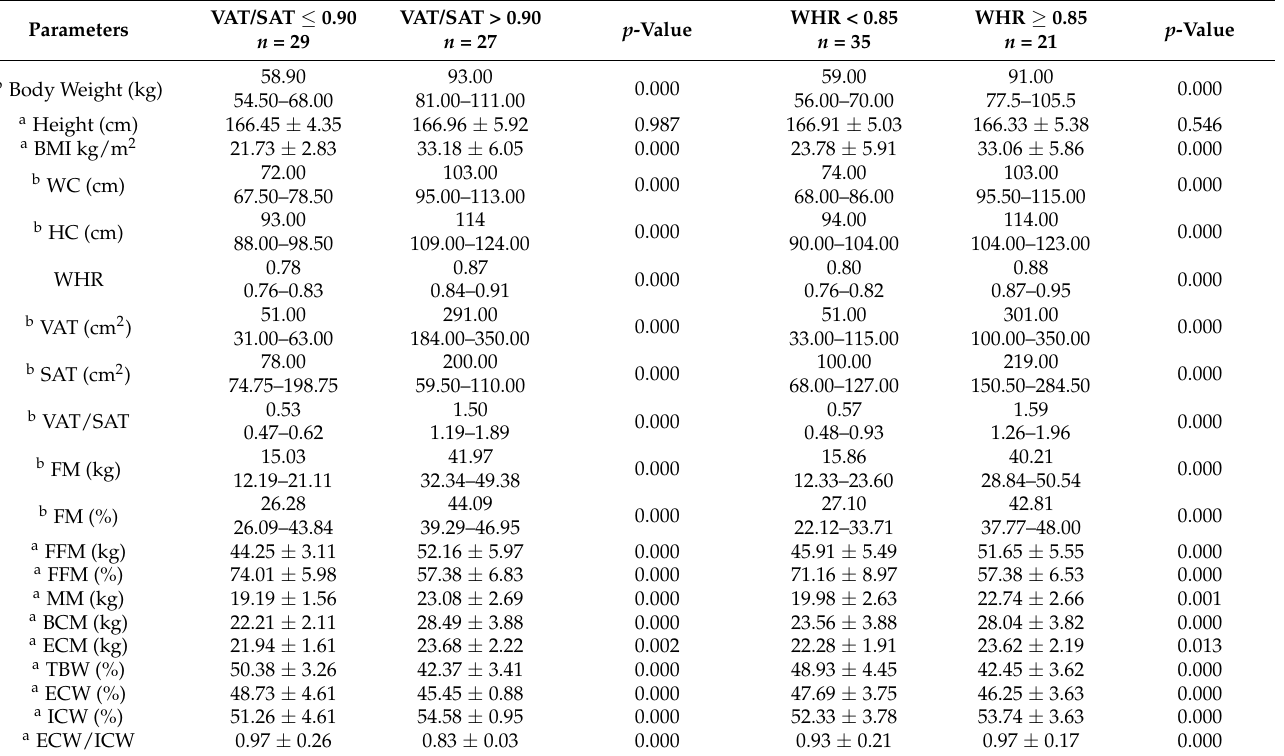
Table 2. Characteristics of anthropometric data and body composition in women with PCOS divided according to the visceral to subcutaneous fat surface ratio and the waist-to-hip ratio